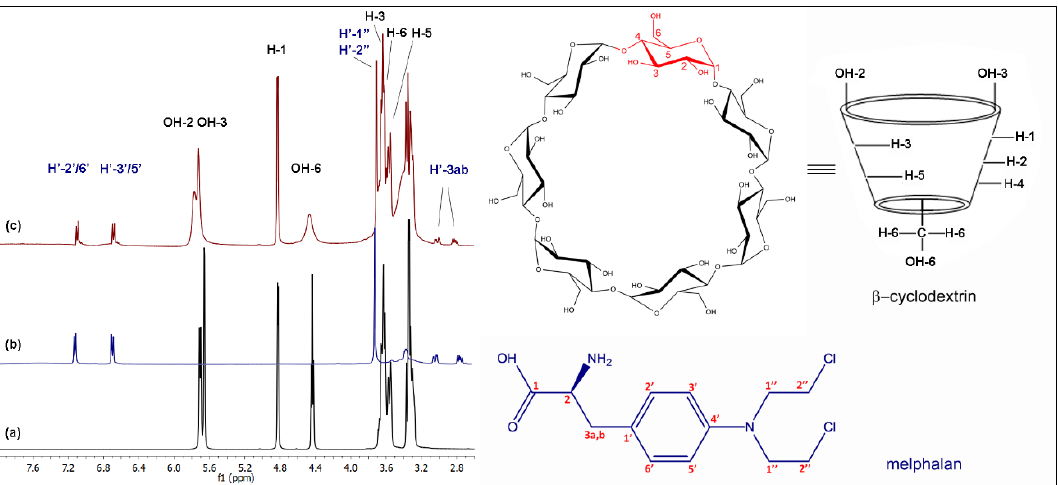
Figure 3. 1 H-NMR spectra of the ( a ) βCD, ( b ) Mel, and ( c ) βCD– Mel complex in DMSO-d 6 .